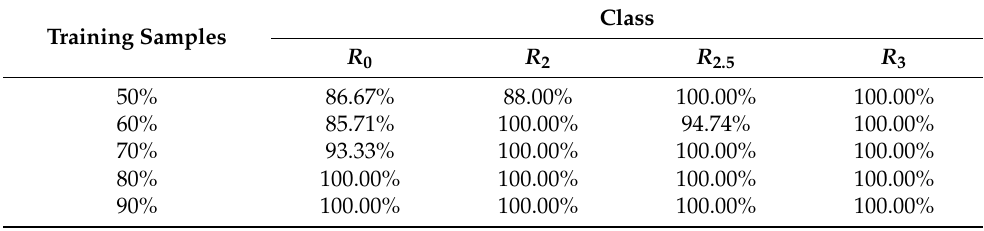
Table 3. The recall rate of the